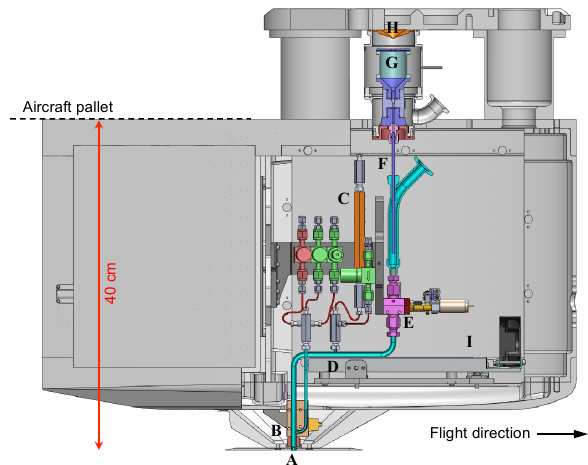
Fig. 2. Model of the CIMS H 2 O inlet pylon showing the inlet geom- etry and components of the flow and calibration system. Ambient air enters the instrument through the sample point (A) in the center of the thin flow straightener plate at the bottom of the pylon. The zero air addition point (B) is located 3cm downstream of the sam- ple point. The principal calibration source is H 2 O produced by H 2 oxidation in a Pt catalyst (C), which is added to the inlet flow (D) 15cm from the sample point. A custom butterfly valve (E) maintains a constant mass flow through the inlet independent of the ambient pressure. A small fraction of the sample flow is extracted through a stainless steel capillary (F) and flows into the ion source (G). Ions produced in the ion source enter the mass spectrometer (not shown) through the entrance nose cone (H). A fan and heater (I) are used to heat the interior of the pylon to near 30 ◦ C during